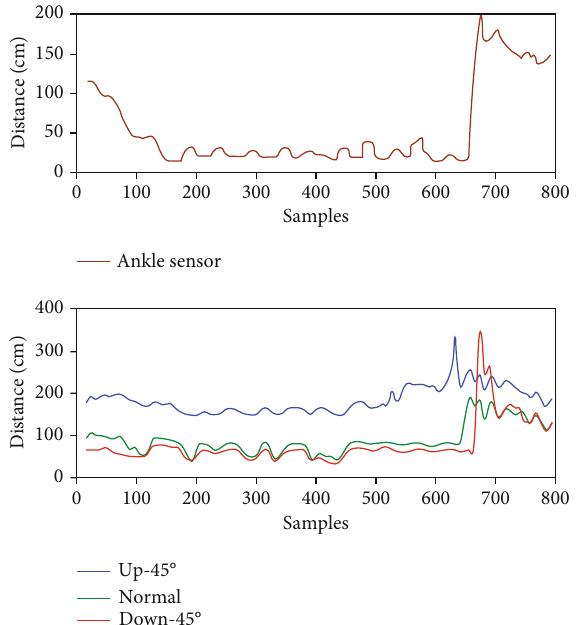
Figure 8: Actual sensor measurements after passing through a moving average fi lter (stairs).